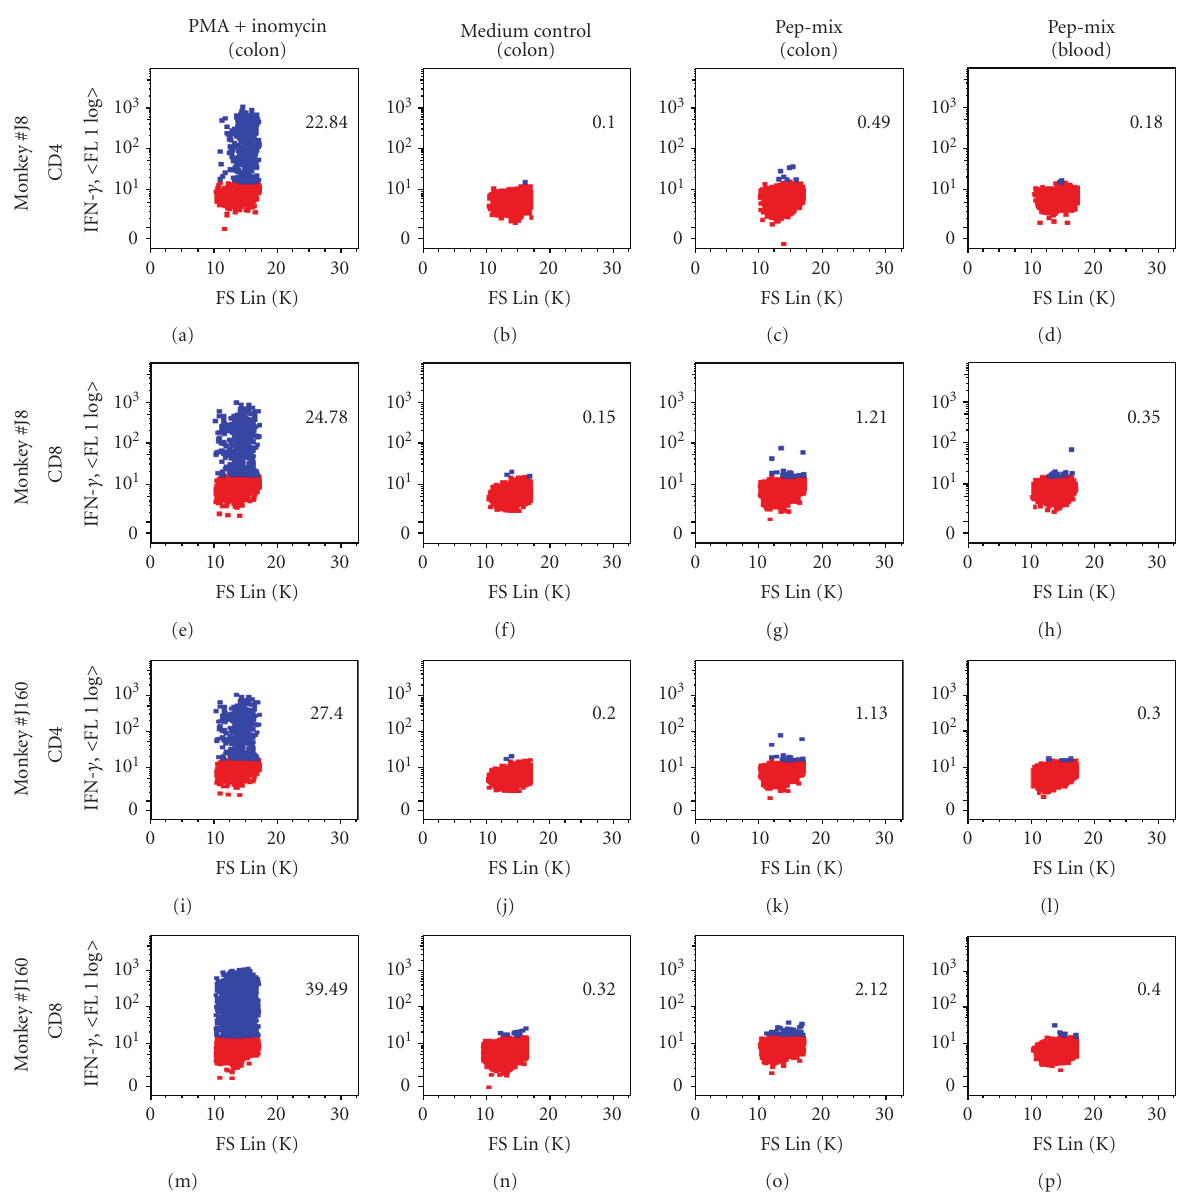
as little as 20 μ g of plasmid DNA by gene gun